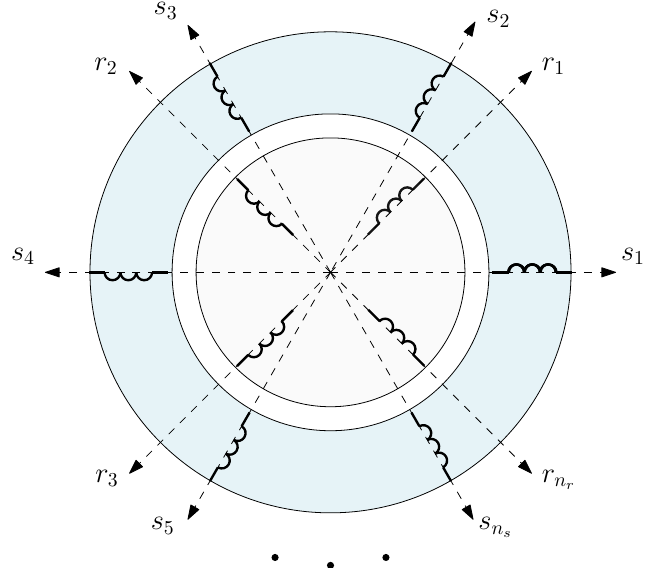
Figure 1. Coordinate system of the IM with an electrical axis rigidly connected to each phase, static in the case of the n s stator windings and moving with the rotor in case of the n r rotor